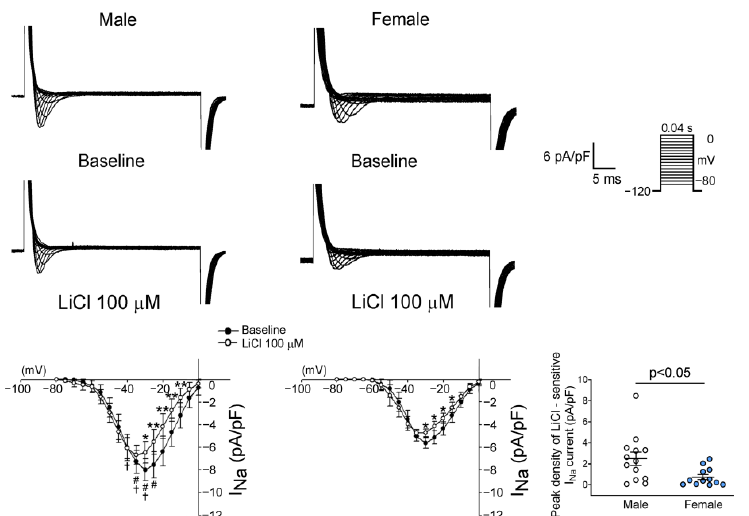
Figure 5. Effects of lithium on the sodium current (I Na ) in right ventricular outflow tract (RVOT) cardiomyocytes. Representative tracings and I-V relationship of the sodium current (I Na ) in male ( n = 14) and female ( n = 14) RVOT cardiomyocytes before and after lithium (100 μM) administration. There was greater lithium-sensitive I Na in male RVOT cardiomyocytes than in female RVOT cardiomyocytes. * p < 0.05, ** p < 0.01, # p < 0.05 male versus female rabbits at baseline, † p < 0.05 male versus female rabbits after lithium (100 μM) administration.